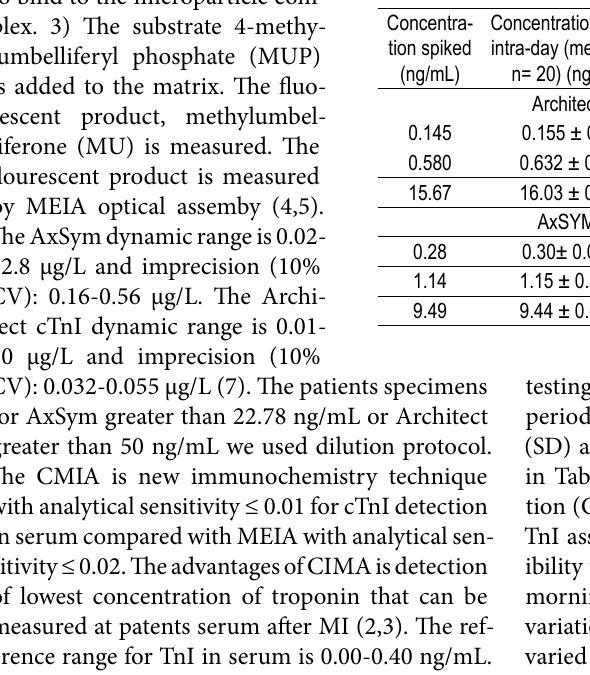
Table 1. Quality control